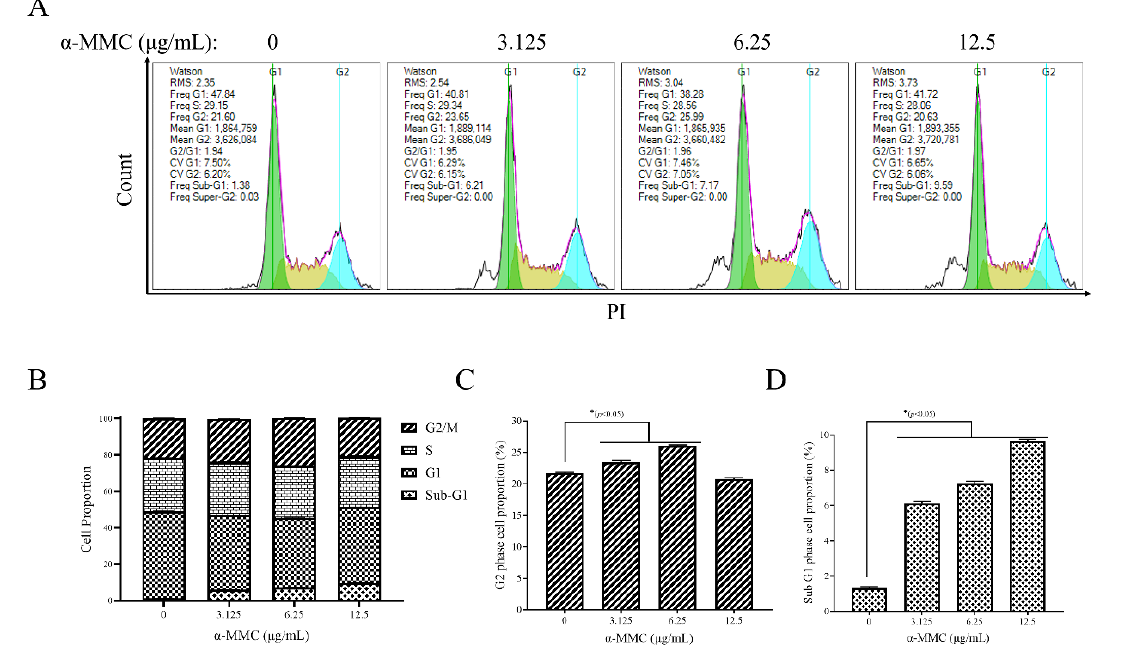
Figure 3. The cell cycle arrest effect of α -MMC on MM.1S cells. After being treated with α -MMC for 12 h, 10,000 counts of PI-stained MM.1S cells were collected via FCM to analyze the cell cycle distri- bution ( A ); GraphPad Prism 9.0 software was used to analyze the proportions of cells in the different phases of the cell cycle ( B ); the cell proportion in the G2 phase ( C ); the cell proportion in the sub-G1 phase ( D ). In the experimental group (3.125, 6.25, 12.5 μg/mL α -MMC group) comparisons with the control group (0 μg/mL α -MMC group), * p < 0.05 was considered to be statistically significant.